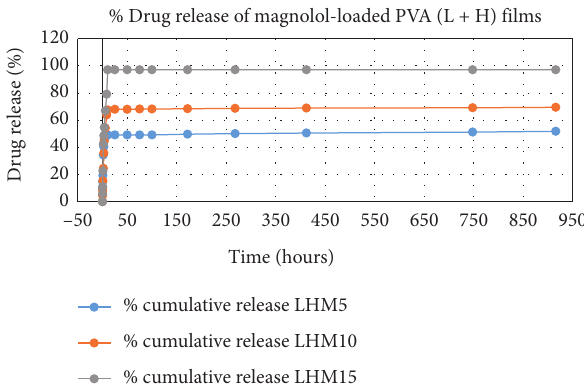
Figure 10: Drug release % of curcumin-loaded PVA (H+L) films.